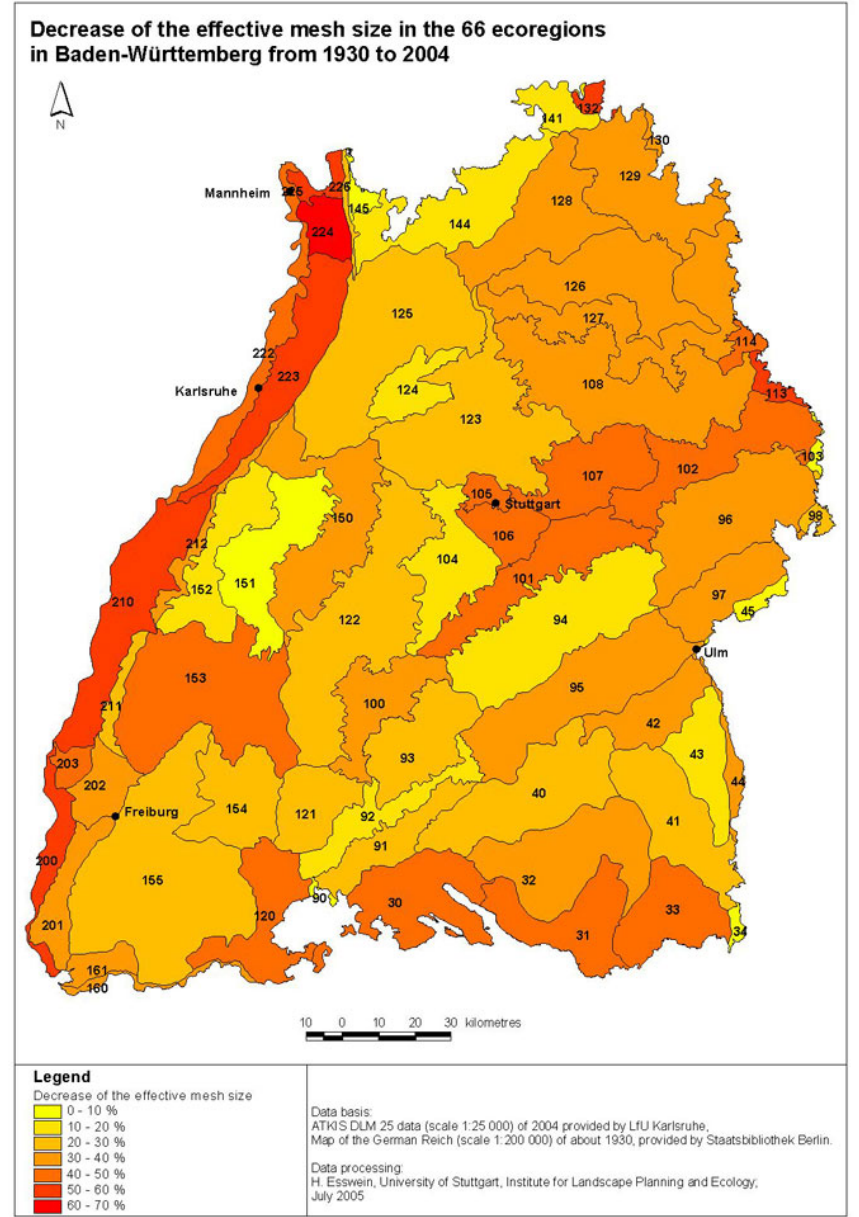
Fig. 7. Development of the degree of landscape fragmentation in terms of effective mesh size ( m km²) within the 66 ecoregions, or natural landscape units, in Baden-Württemberg from 1930 to 2004 (fragmentation level “including municipal roads”). The change in m 1930 results. The identification numbers and names of the ecoregions are given in the legend to Fig. 6. (Click here to view or download a high resolution pdf version. File size: 269